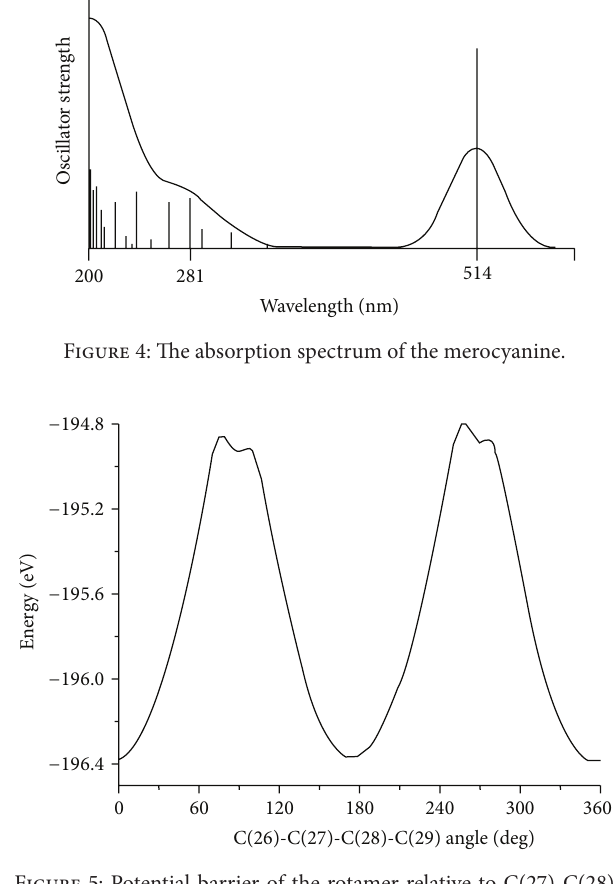
Figure 5: Potential barrier of the rotamer relative to C(27)-C(28) bond.